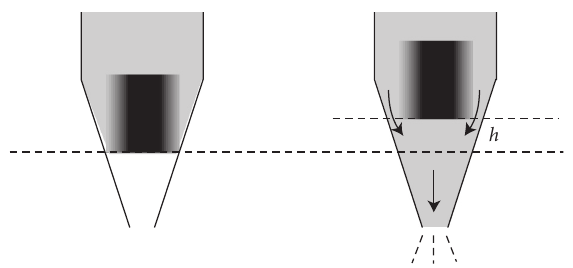
Figure 4: Working principle of fuel